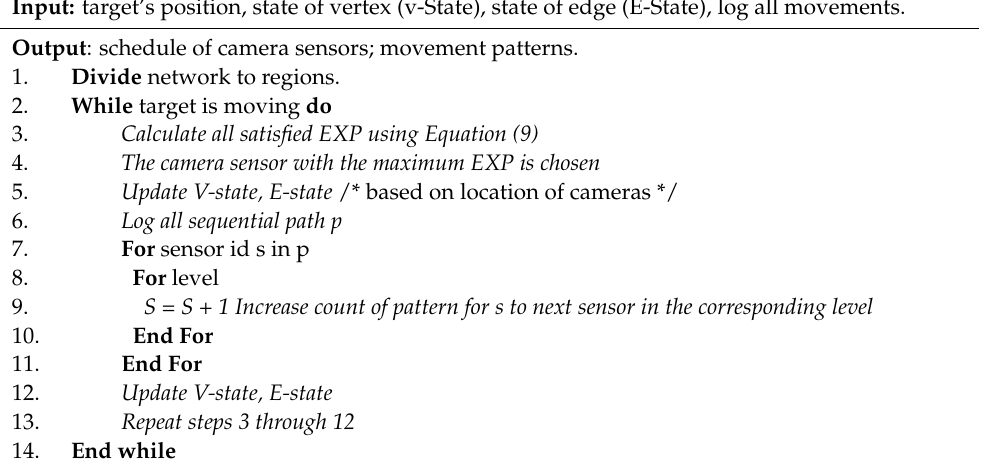
Algorithm 1: movement pattern generation and cooperative relay algorithm for single